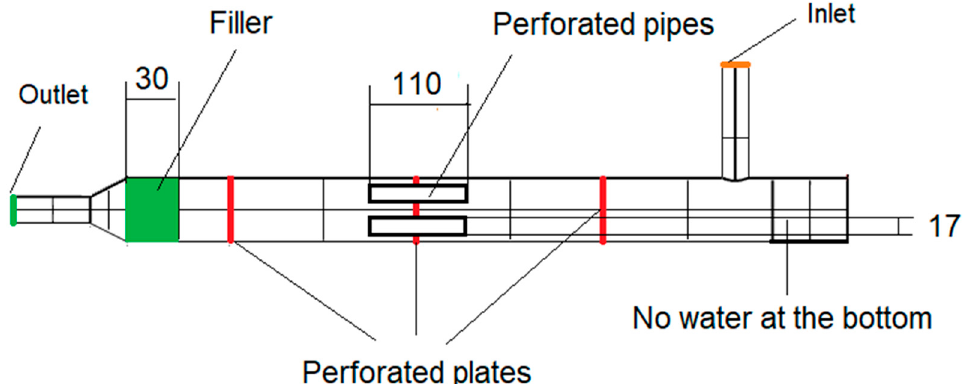
Figure 16. Model-scale scrubber geometry modifications.